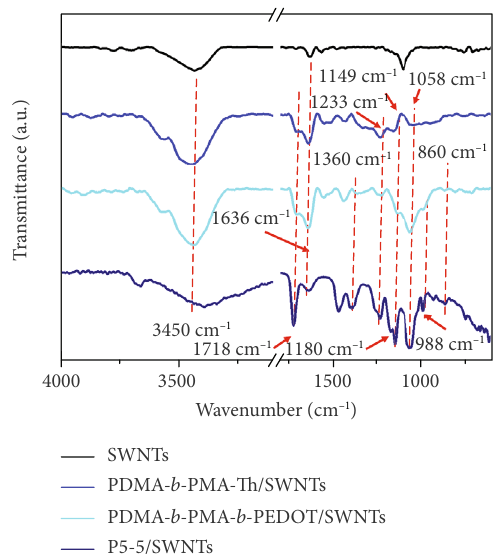
Figure 2: Infrared spectrogram of pristine SWNTs and modi fi ed nanotubes.